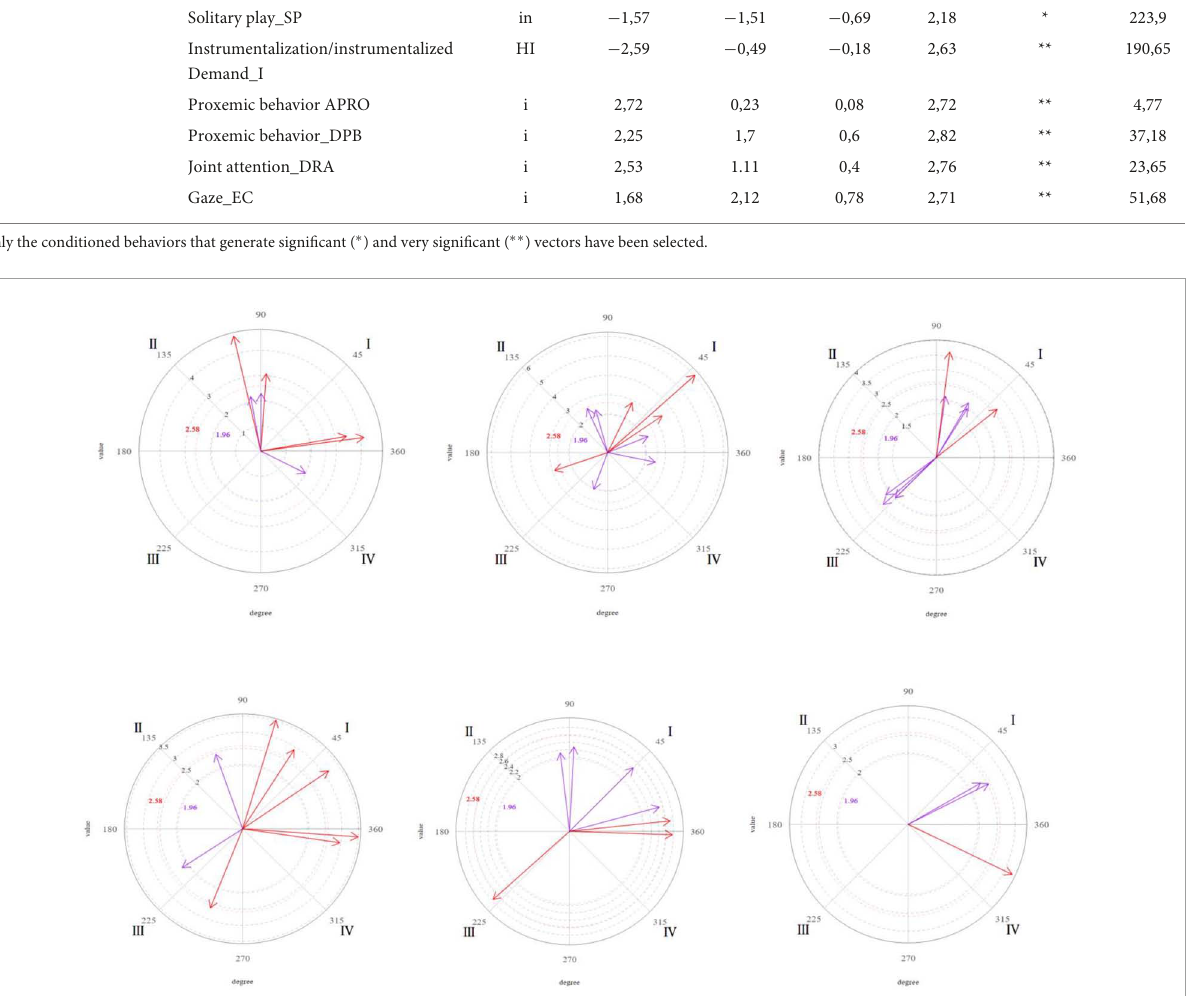
In the analysis of the child’s clinically favorable behaviors, the therapist’s verbalization was related with 78.9% of clinically favorable behaviors ( χ 2 = 6.53; df = 1; p = 0.01) and